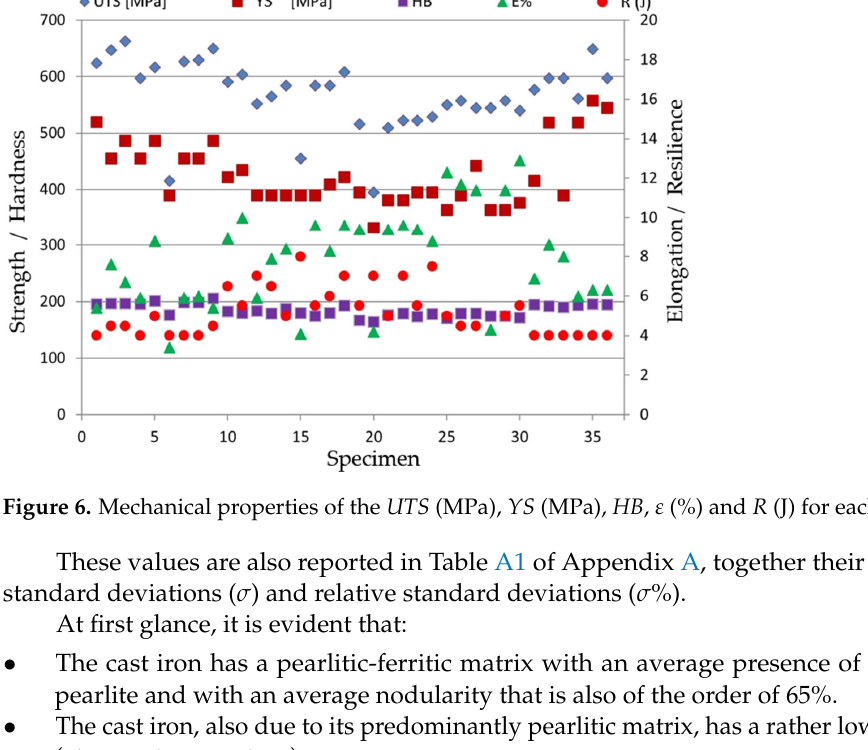
Figure 5. Ferrite, pearlite and graphite contents with respect to each specimen.